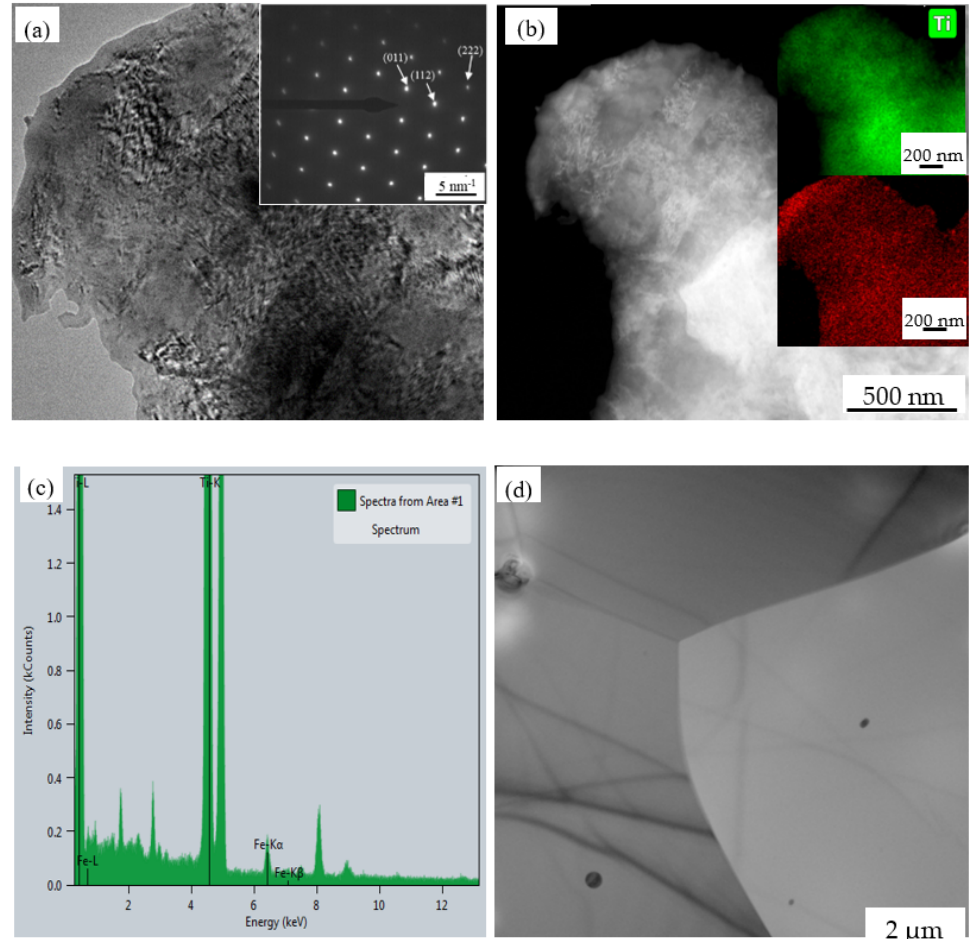
Figure 2. TEM images and EDS of annealed Gr.4 strip: ( a ) TEM bright field (BF) image showing the β phase in the grain, the insert corresponds to the selected area electron diffraction pattern (SAEDP), ( b ) high-angle annular dark-field (HAADF) image and scan map of Ti and Fe, ( c ) spectra from area of ( b ), and ( d ) TEM BF image of the grain boundary (GB).